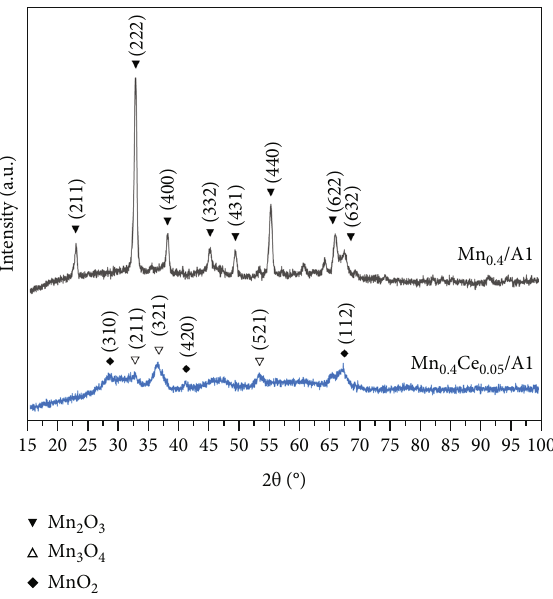
Figure 3: XRD patterns of Mn